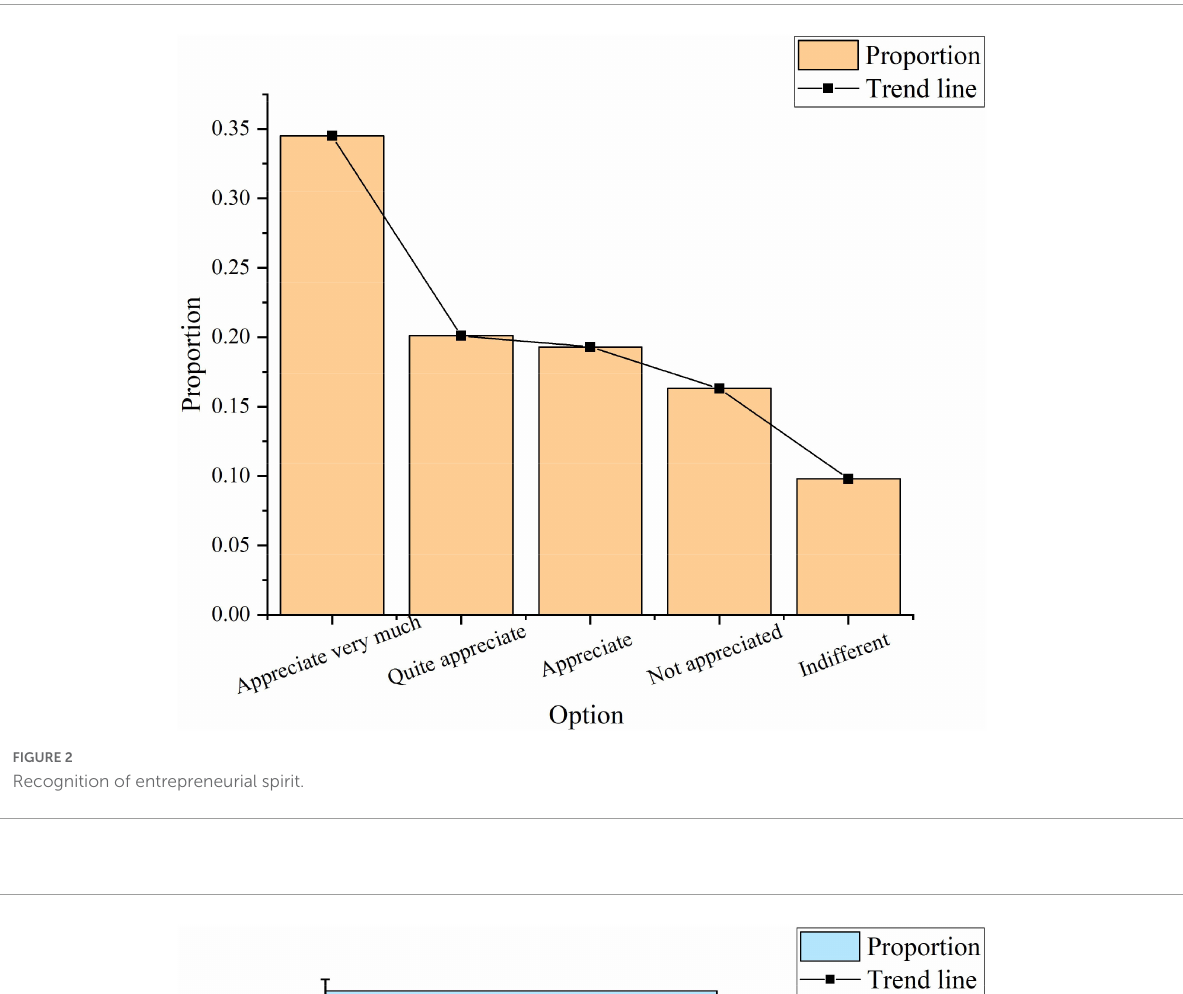
FIGURE2 Recognition of entrepreneurial spirit.